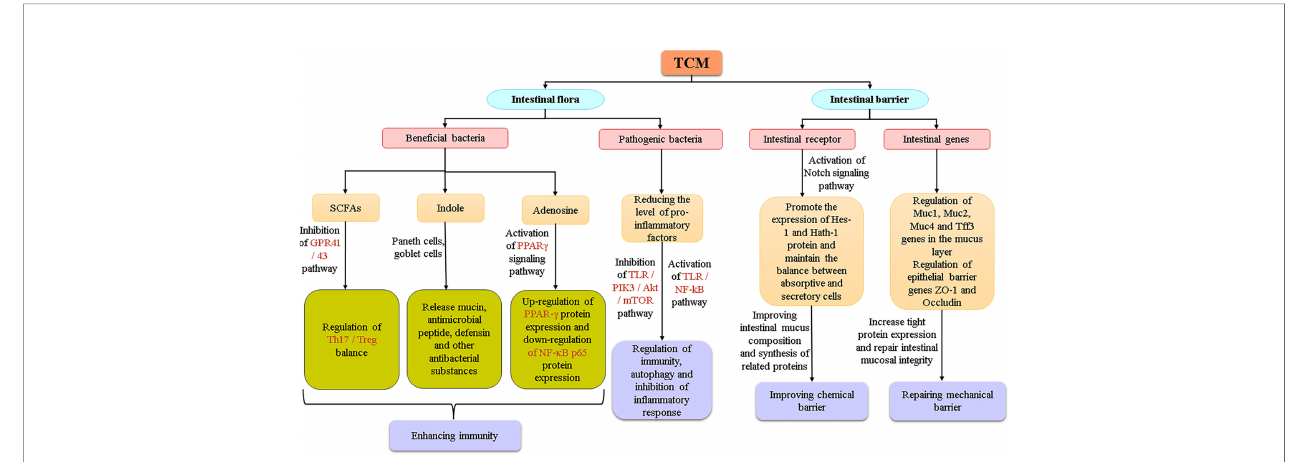
FIGURE 5 | The relationship between intestinal fl ora and the intestinal barrier system under the action of TCM.